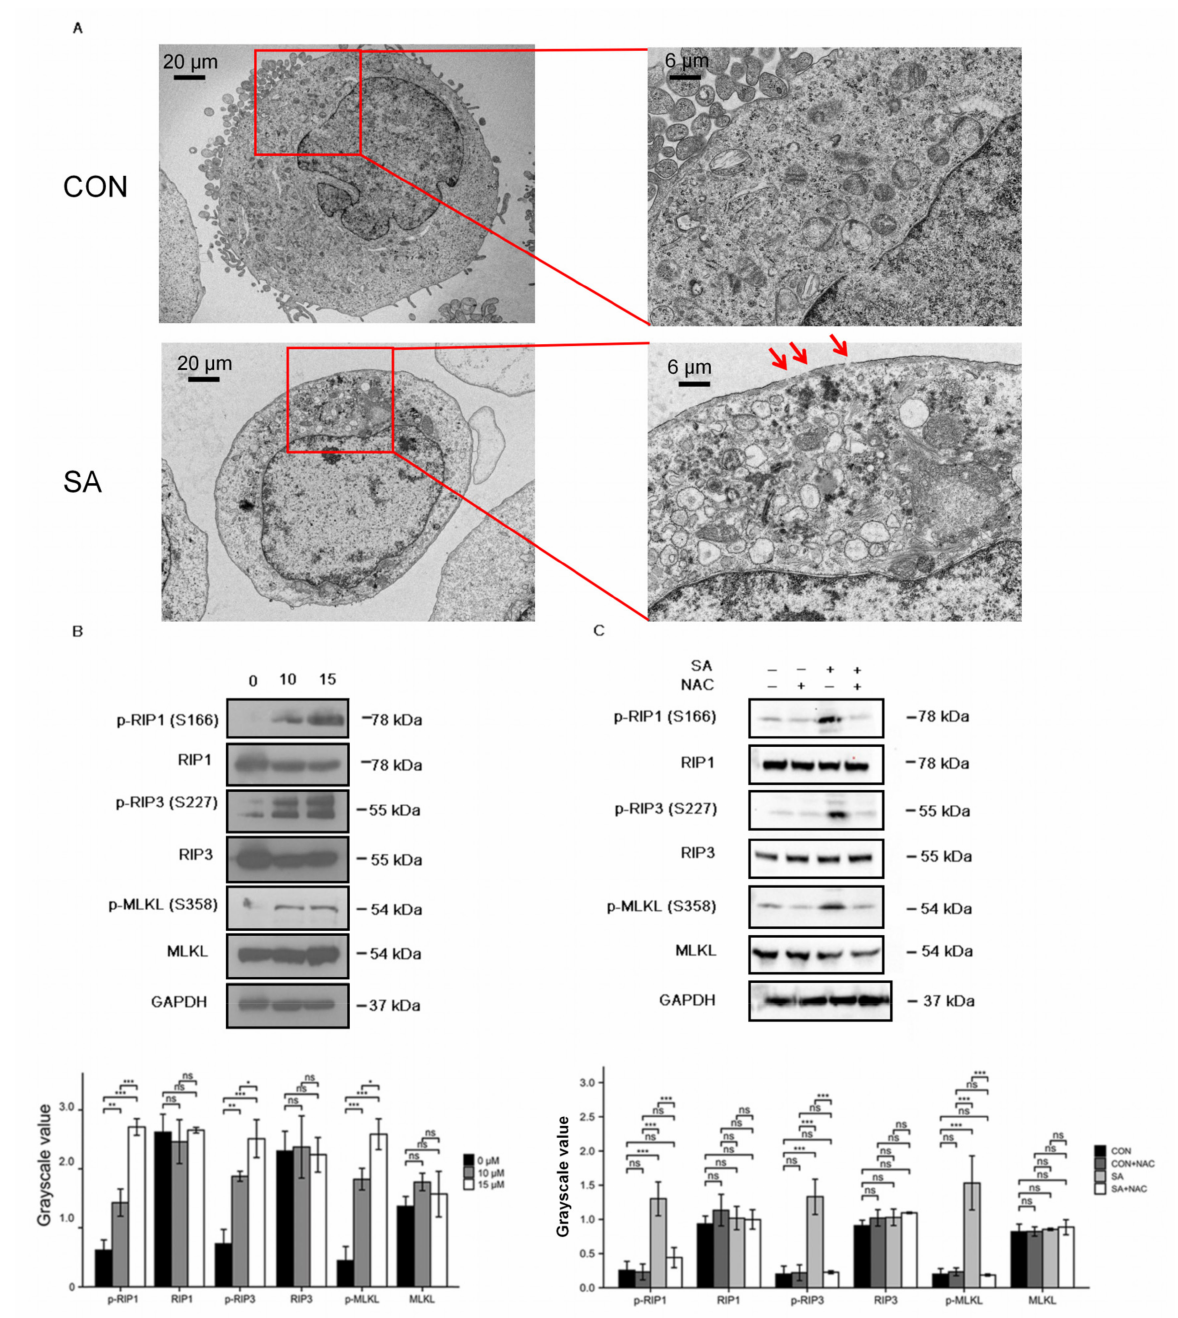
Figure 4. Scabertopin-treated J82 cells undergo necroptosis, which can be rescued by NAC. ( A ) TEM images are shown for the control group (CON) and the J82 cells treated with 10 µ M of scabertopin (SA) for 24 h. The image on the right is an enlarged image of the left image, and the red arrow points to the perforation on the cell membrane during necroptosis; at least three independent samples were observed in each group. ( B ) Scabertopin can significantly increase the phosphorylation of the necroptosis-related proteins RIP1, RIP3, and MLKL (n = 3) after 24 h of treatment; ( C ) Scabertopin- induced phosphorylation of RIP1, RIP3, and MLKL can be reversed by NAC in the group treated with 10 µ M of scabertopin for 24 h. A total of 5 µ M of NAC was used in the experiments. The grayscale values are normalized to GAPDH. Data represent the mean ± s.e.m. of the three independent experiments. * p < 0.05, ** p < 0.01, *** p < 0.001, ns: no significance vs. 0 µ M scabertopin-treated group. MLKL: mixed lineage kinase like; NAC: N-acetylcysteine; p-: phosphorylated; RIP1: receptor- interacting